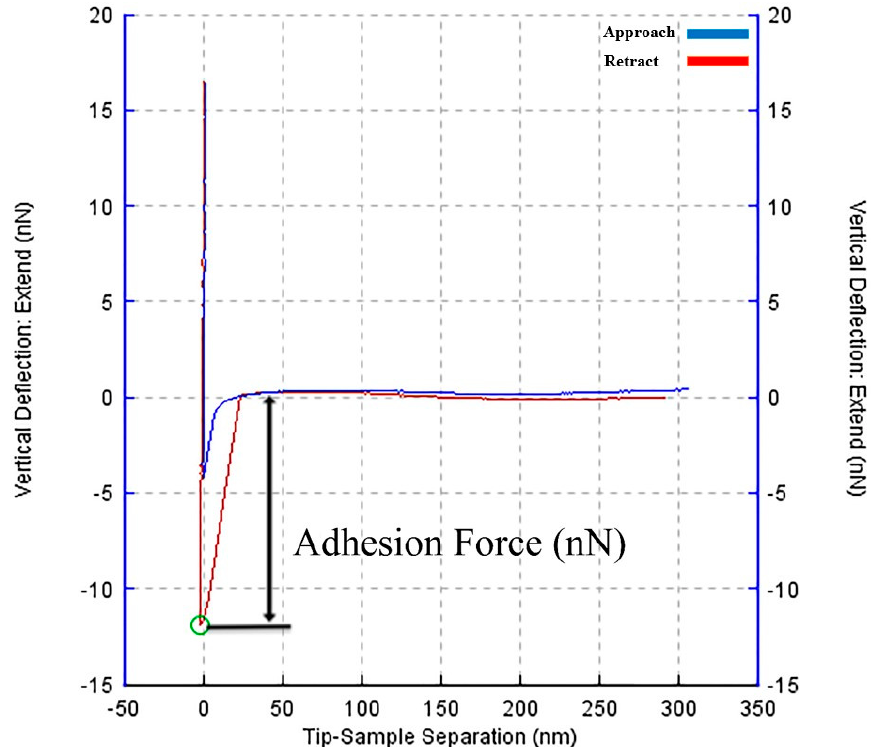
Figure 6. A force-distance curve from the atomic force microscope (AFM). While the vertical axis depicts the applied force to the tip, the horizontal axis represents the tip displacement. The tip jumps toward the surface when it approaches the surface. This phenomenon happens due to the existence of Van der Waals, the electrostatic and capillary forces, known as adhesion forces [32]. The double arrow from the zero line represents the adhesion force. To increase the reliability of the calculated adhesive force, the measurements were made at several points. A grid of 16 squares was considered for each sample (Figure 7), and the adhesion force was determined for the center of each